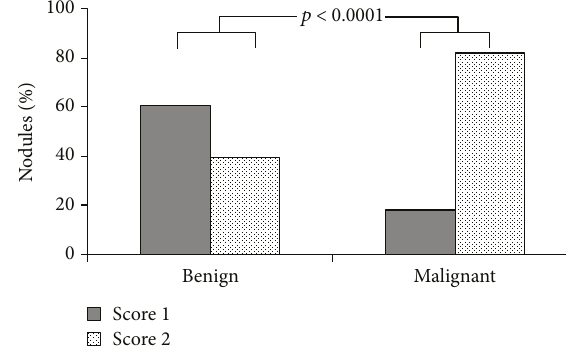
Figure 2: Analysis of all 242 nodules with valid cytological specimens: strati fi cation of benign and malignant nodules in accordance to the number of vessels visualised by SMI. Score 1: maximum two blood vessels. Score 2: three or more